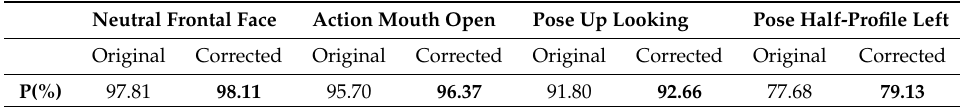
Table 4. Face landmark correction